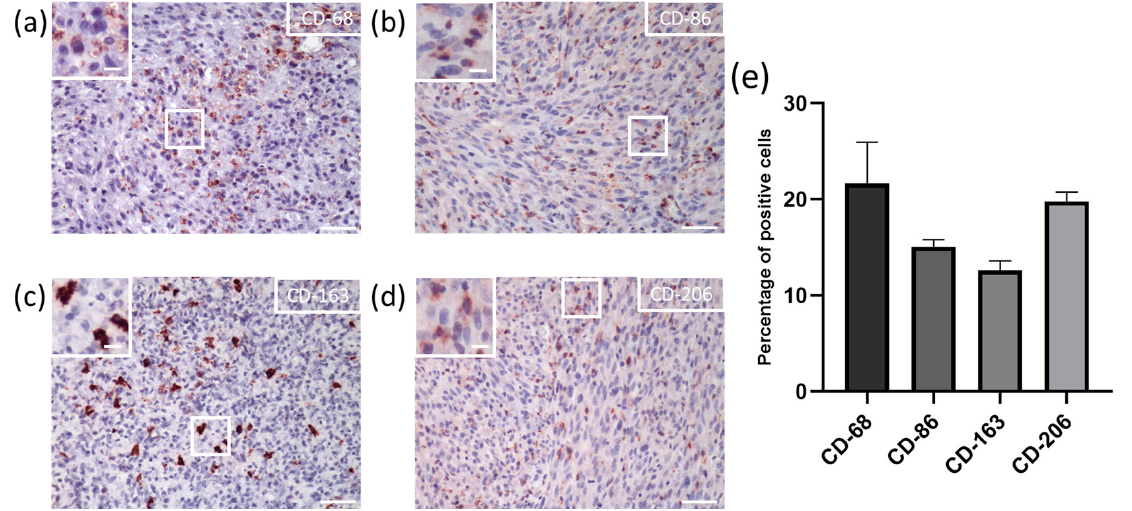
Figure 1. In vivo macrophage population in U87 tumor tissue. General view of ( a ) CD-68, ( b ) CD- 86, ( c ) CD-163, and ( d ) CD-206 immuno-histochemical staining (scale = 50 µm in major squares; 10 ( c ) CD-163, and ( d ) CD-206 immuno-histochemical staining (scale = 50 µ m in major squares; 10 µ m in µm in minor squares); ( e ) percentage of M2 macrophages in fi ltration throughout the tumor tissue. minor squares); ( e ) percentage of M2 macrophages infiltration throughout the tumor tissue. Mean Mean percentage of positive cells ( n = 3, mean ± SD). percentage of positive cells ( n = 3, mean ±